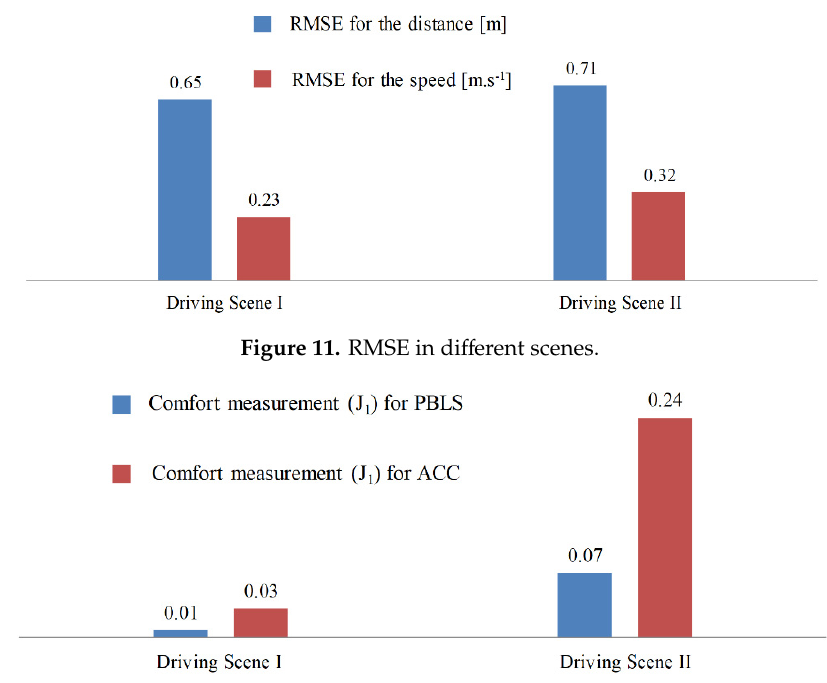
Figure 10. Acceleration and jerk (J 2 ) for Driving Scene II.